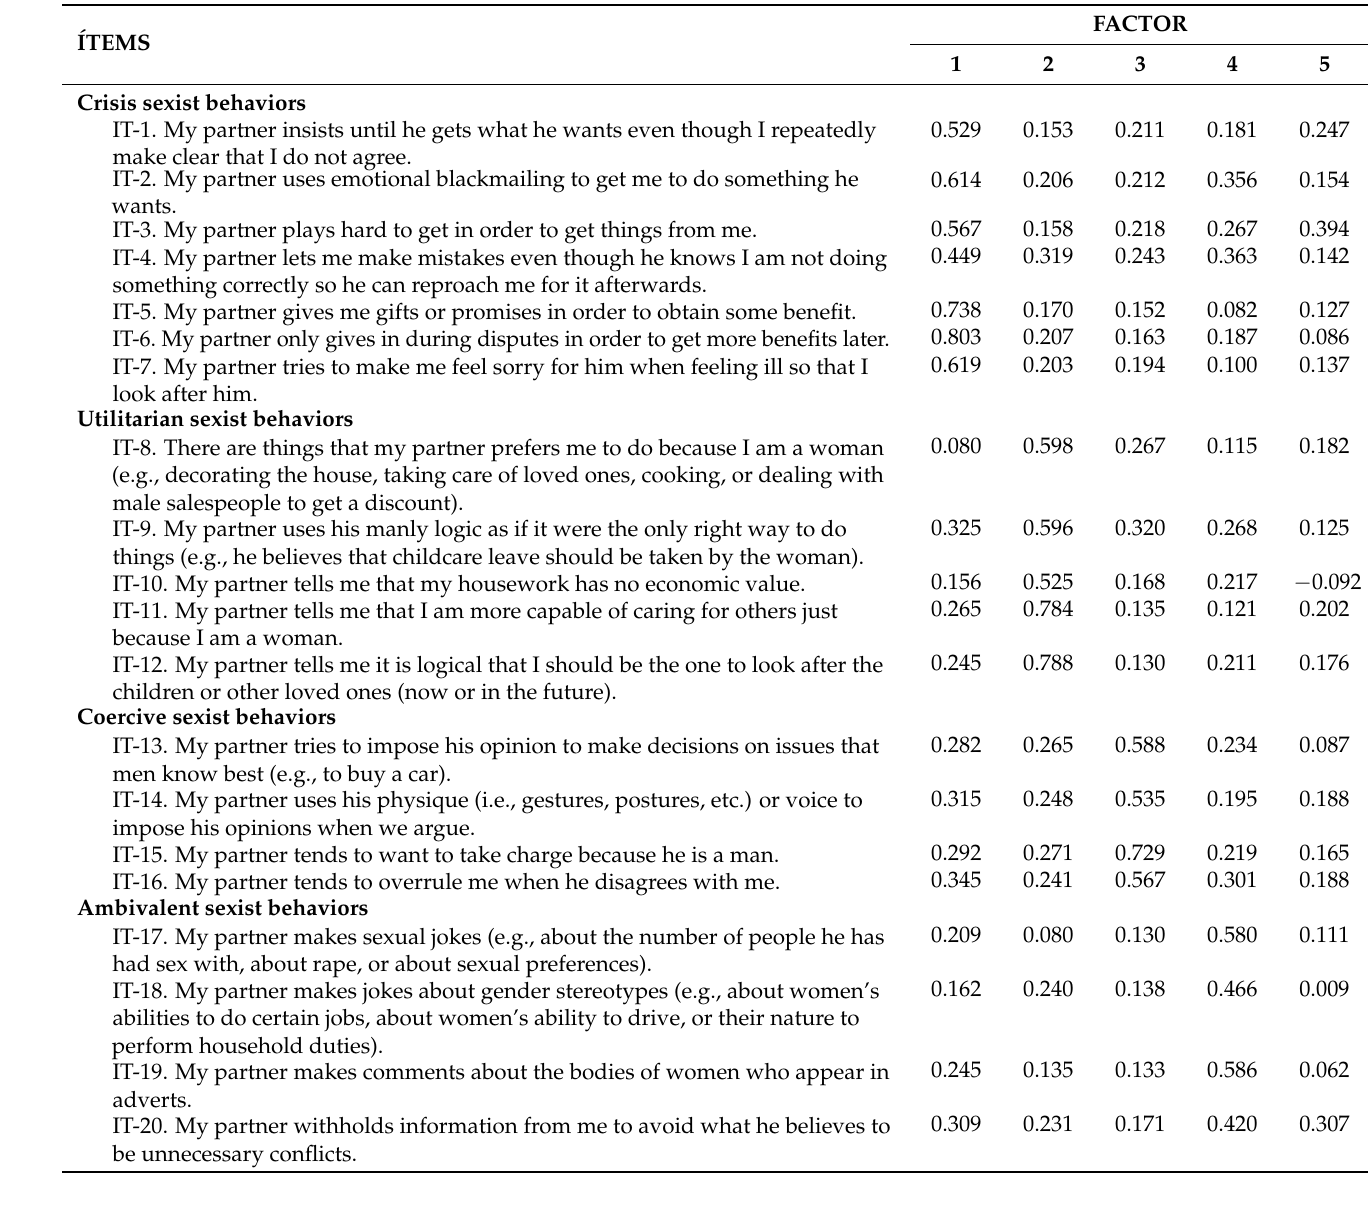
Table 3. Results of the exploratory factor analysis of the Q-IVAW ( N =